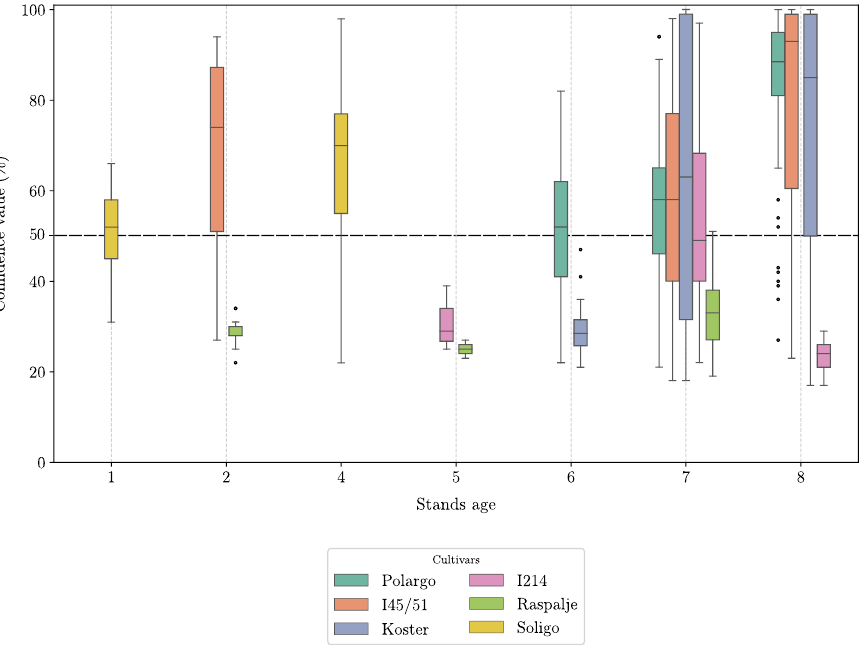
Figure 11. Map extracts located in the Gironde department in tile 30TYQ: ( a ) is the 2018 orthophoto, ( b ) the confidence map with a red-yellow-green scheme palette for the classified poplars (the highest confidence rates are in green), and ( c ) shows the overlay of the forest mask derived from the national forest database (BDForêt ® IGN, v.2) on the confidence map.